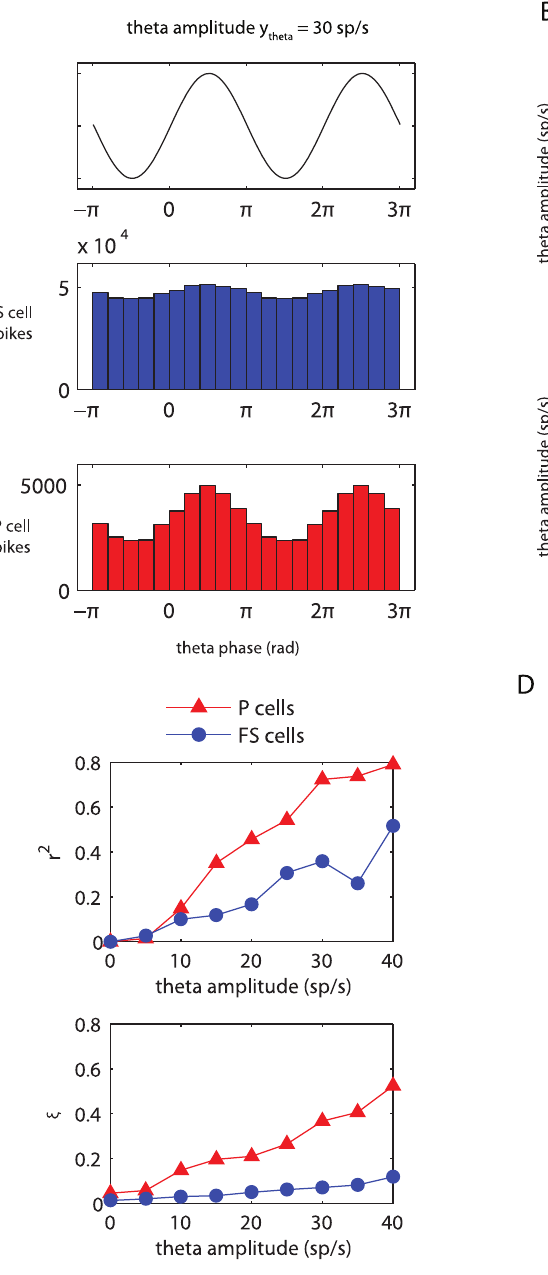
Figure 4. Theta modulation of fast-spiking and pyramidal cell spike times. Fast-spiking cells received, on average, twice as many theta- modulated input synapses as the pyramidal cells, which, relative to the total input, is four times as many (see main text for details). (A) Spike histograms for the fast-spiking (blue, middle) and pyramidal (red, bottom) cells relative to theta phase. The amplitude of the incoming theta rhythm was set to y h ~ 30sp = s (see equation 8). Histogram bin size is 25ms . Above the spike histograms, the ‘raw theta signal’ (see equation 14) is plotted, to show which phases in the theta cycle correspond to peaks and troughs. (B) Spike counts (color code) relative to theta phase (x-axis) for the fast- spiking (top) and pyramidal (bottom) cells as a function of theta amplitude y h (y-axis). Spike count bin size is 25ms and bins were non-overlapping. (C) Two different measures of theta modulation of spike times: Pearson’s r 2 (top) and relative modulation amplitude j (bottom; see equation 15) as a function of incoming theta amplitude y h . (D) The same two measures as a function of theta input